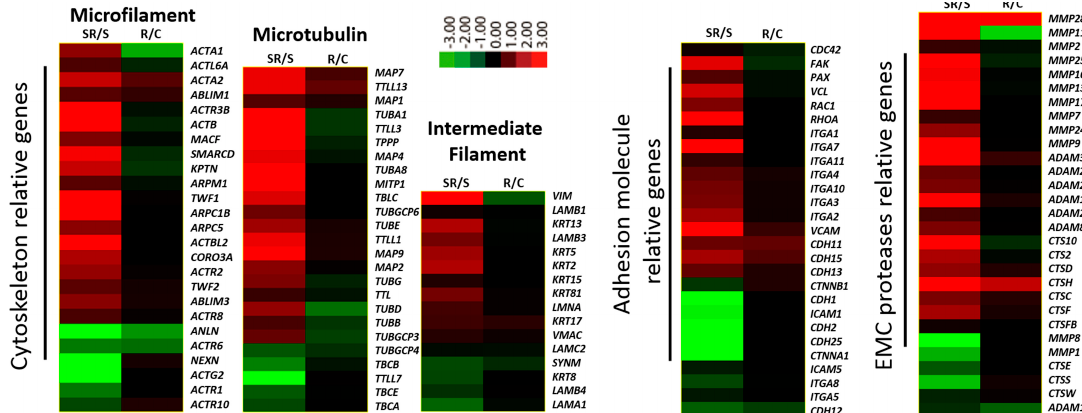
Figure 2. Heat map representations of alterations in expression of metastasis-associated genes in the different treatment groups. The full gene names can be found in Table S1. The fold-changes of SR/S and R/C are illustrated by the color bar, which shows the corresponding log (2) values. C, Control; R, Radiation; S, starvation; SR, starvation + radiation.